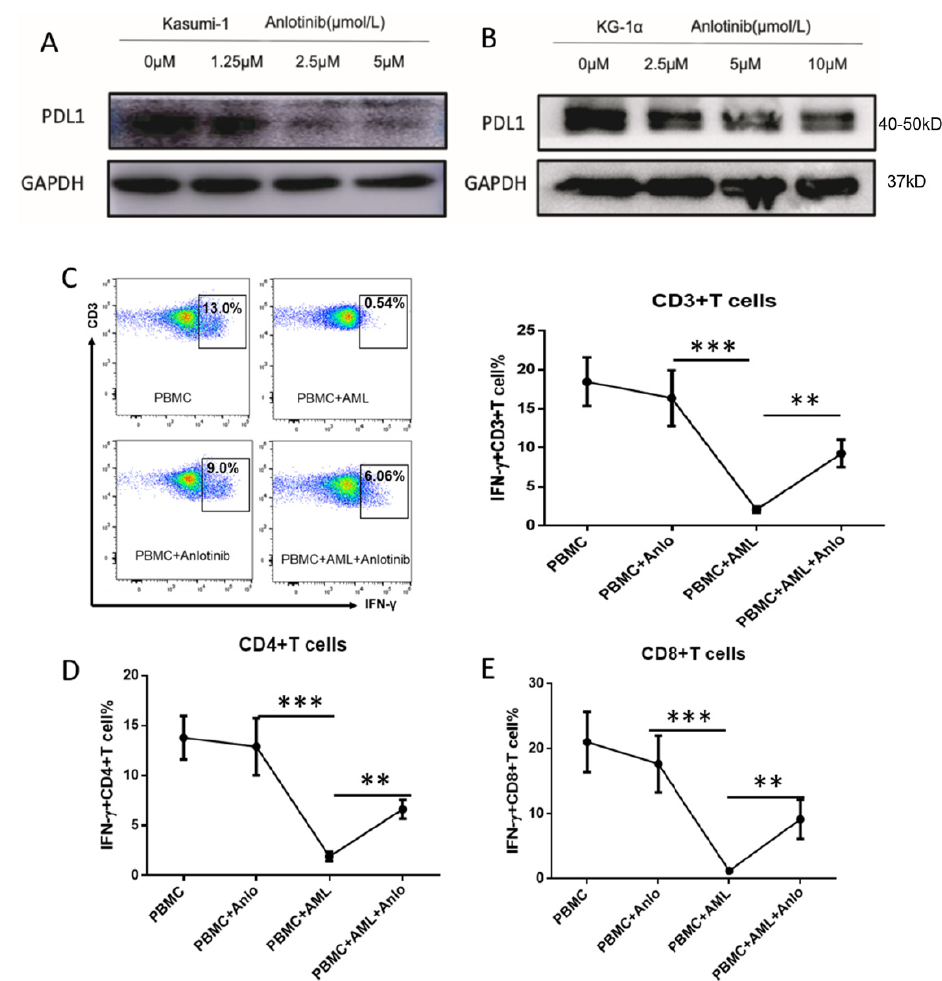
Figure 6. Effects of anlotinib on immune-evasion potential of LSC-like cells. ( A , B ) Western blot analysis of PD-L1 expression in Kasumi-1 cells ( A ) and KG-1 α cells ( B ) after anlotinib treatment with indicated concentration for 12 h. ( C , D ) IFN- γ production in CD3 + T cells ( C ), CD4 + T cells, ( D ) and CD8 + T cells ( E ) in the indicated groups ( n = 6/group). ** p < 0.01, *** p < 0.001.